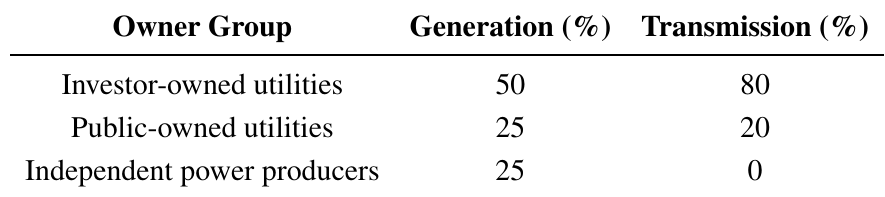
Table 5. Ownership Breakdown for the USA Electricity Grid, in percent breakdown for generation and transmission